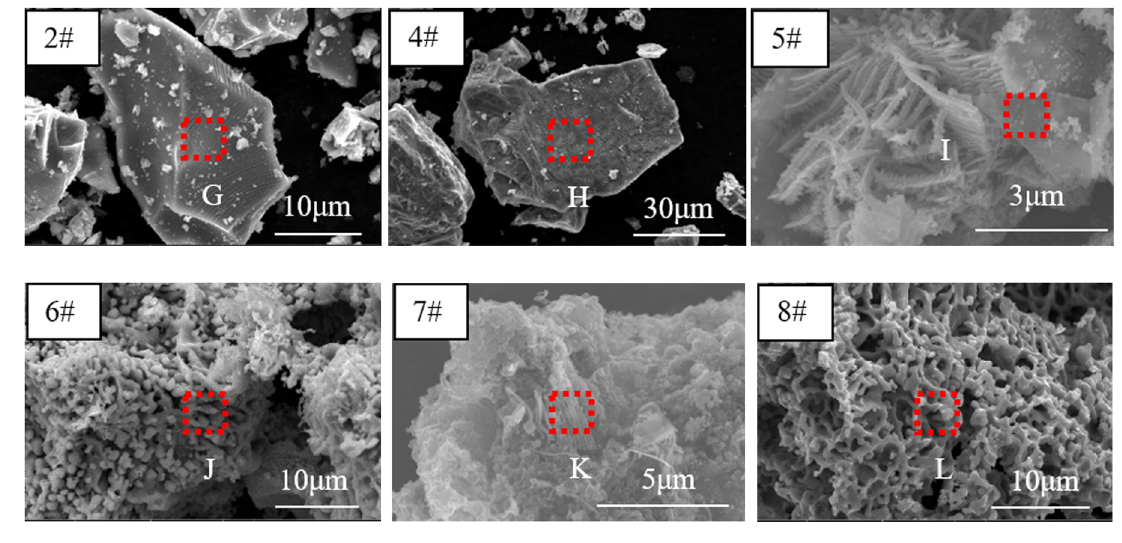
Figure 6: Microstructure of products after pickling.